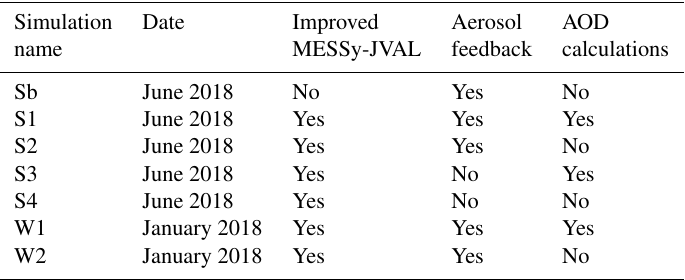
Table 4. List of simulations performed in this study. Simulation Date Improved Aerosol AOD name MESSy-JVAL feedback calculations Sb